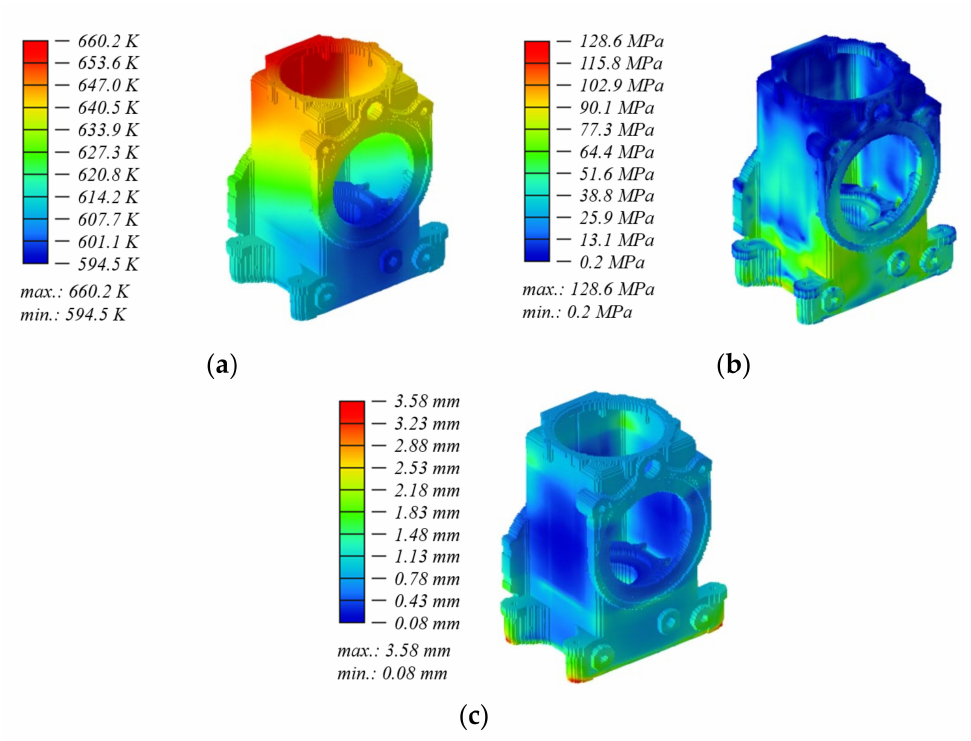
Figure 6. Output fields in the growing volume: ( a ) temperature, ( b ) equivalent stresses and ( c ) displacements.